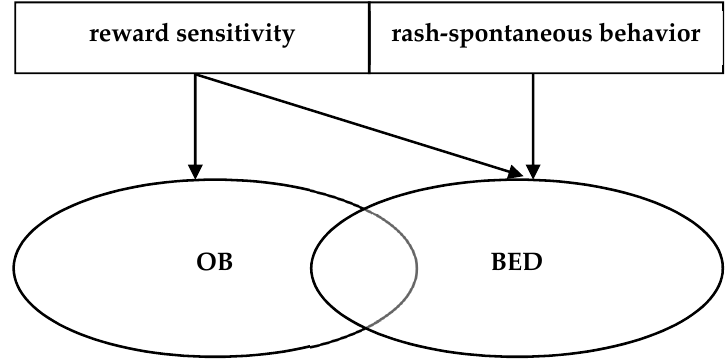
Figure 2. Model of impulsivity deficits in obese patients with and without BED, adapted from Schag et al., 2013 [5]. OB: patients with obesity; BED: patients with Binge Eating Disorder.